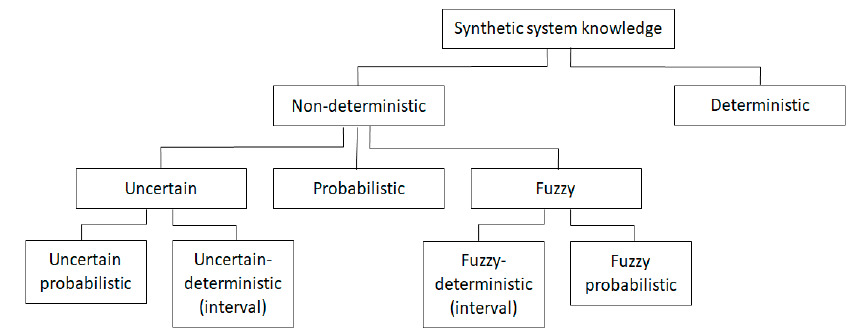
Figure 2. Categorization of non-deterministic system knowledge.